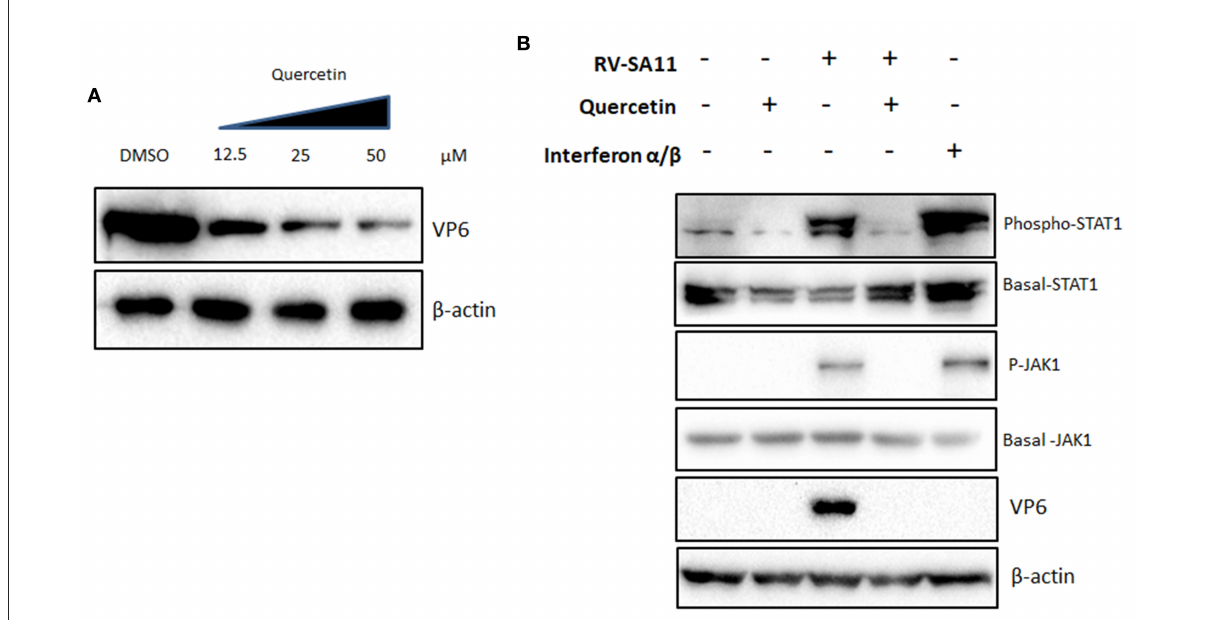
FIGURE3 The inhibitory function of quercetin on rotavirus infection is independent of interferon signaling (A) Type I IFN signaling mutant vero cells were infected with RV-SA11 (MOI 3) in the presence of increasing concentrations of quercetin (12.5, 25, and 50 µ M) for 12 hpi and cell lysates were subjected to Western blot to evaluate the expression of VP6, whereas β -actin was taken as internal loading control. (B) The activation of JAK1-STAT1 signaling was checked by Western blot performed from MA104 cell lysates mock-infected or RV-SA11-infected and treated with either DMSO or quercetin (50 µ M). IFN α / β conjugate (500 units/ml) was treated as positive control. Protein expression and phosphorylation of JAK1 and STAT1 were assessed along with β -actin as internal loading